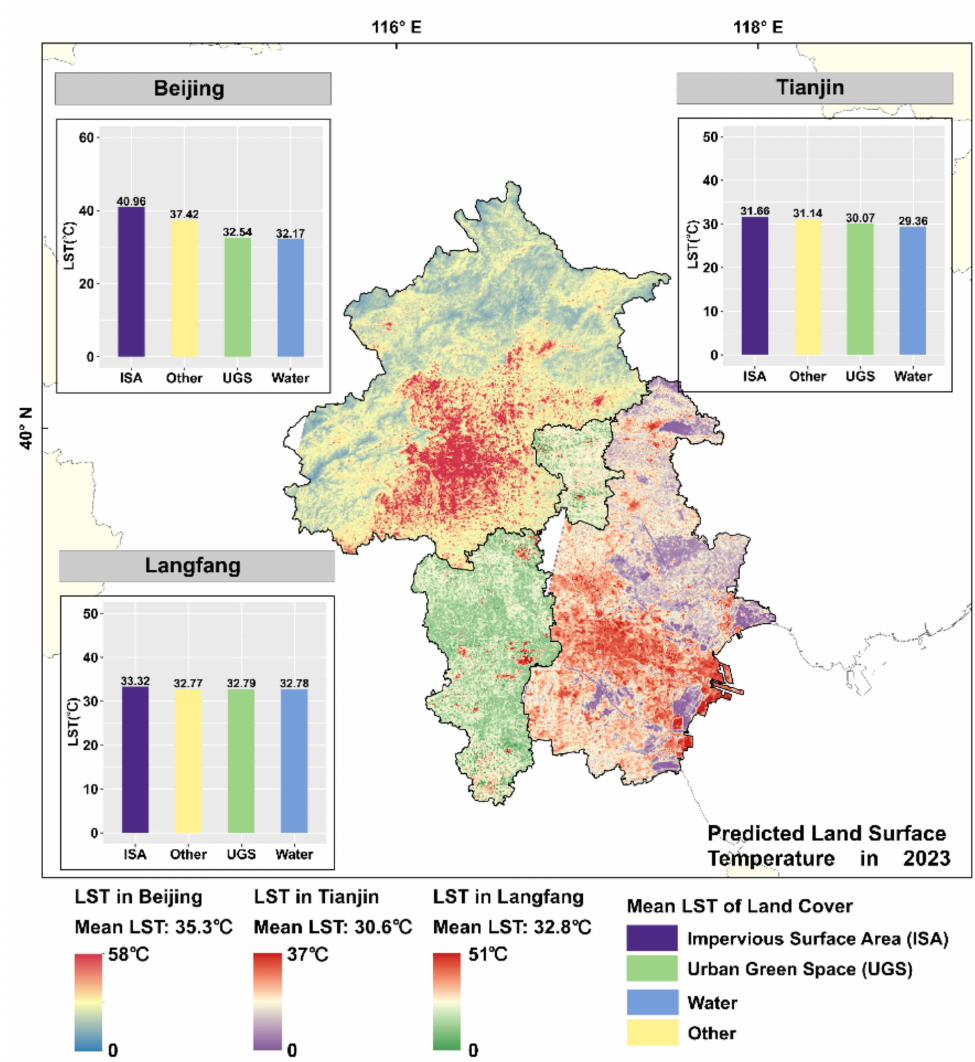
Figure 14. Predicted LST and the average LST corresponding to each LCS in 2023 across Bei- jing, Tianjin and Langfang using the BP neural network model under the natural scenario of the LCS